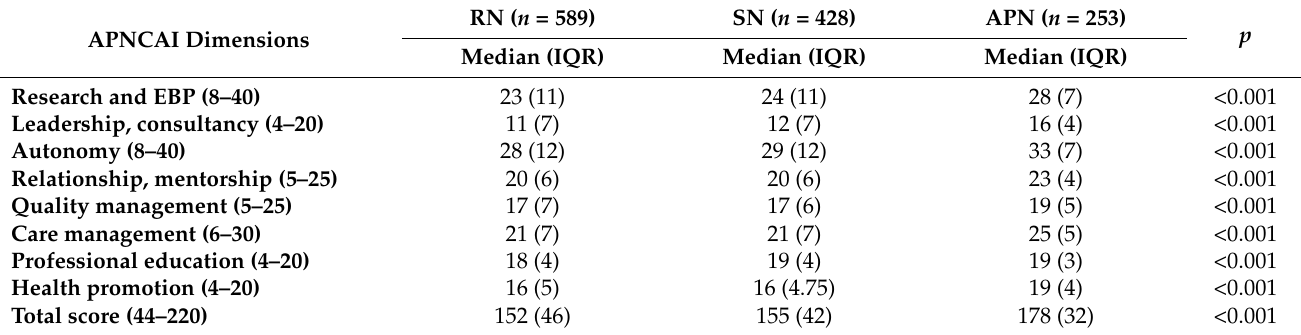
Table 2. Gradient of scores between RNs, SNs and